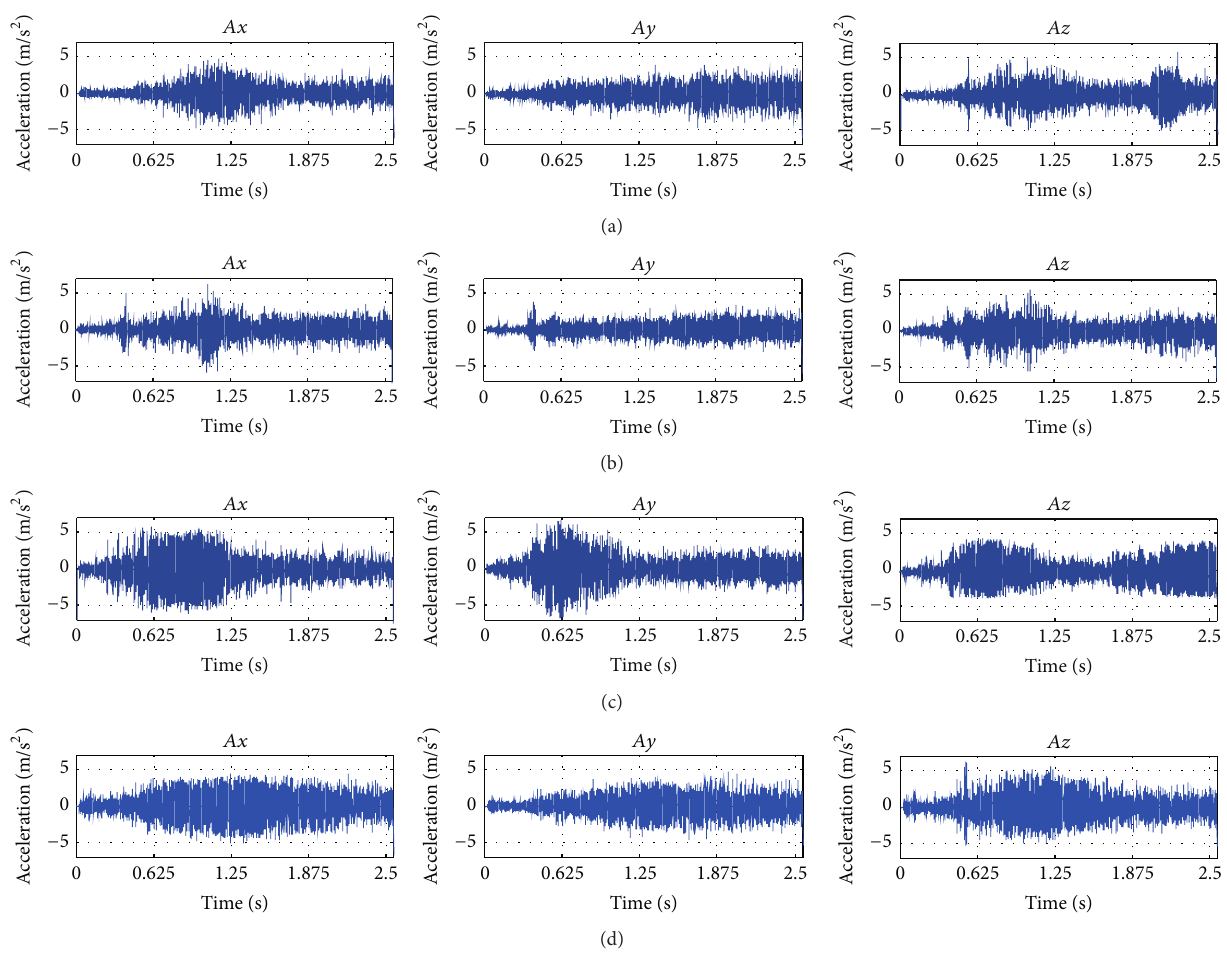
Figure 3: Vibration signals for startup transient: (a) HLT, (b) HBRB, (c) 1BRB, and (d) 2BRB.